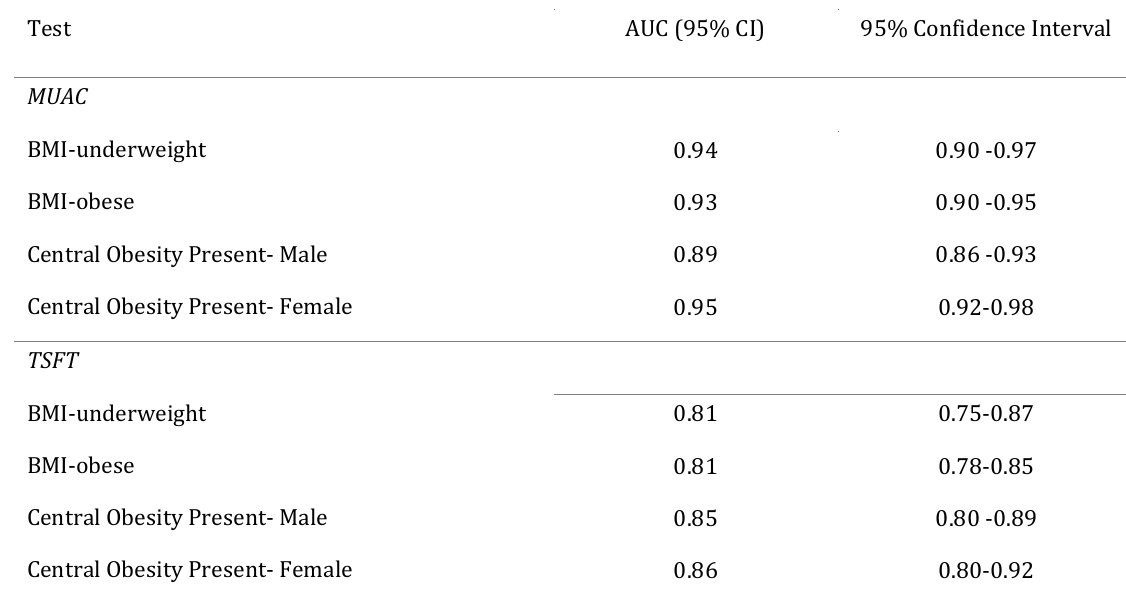
Table 2: Validity of MUAC and TSFT as alternatives for BMI- Area Under ROC (AUROC)